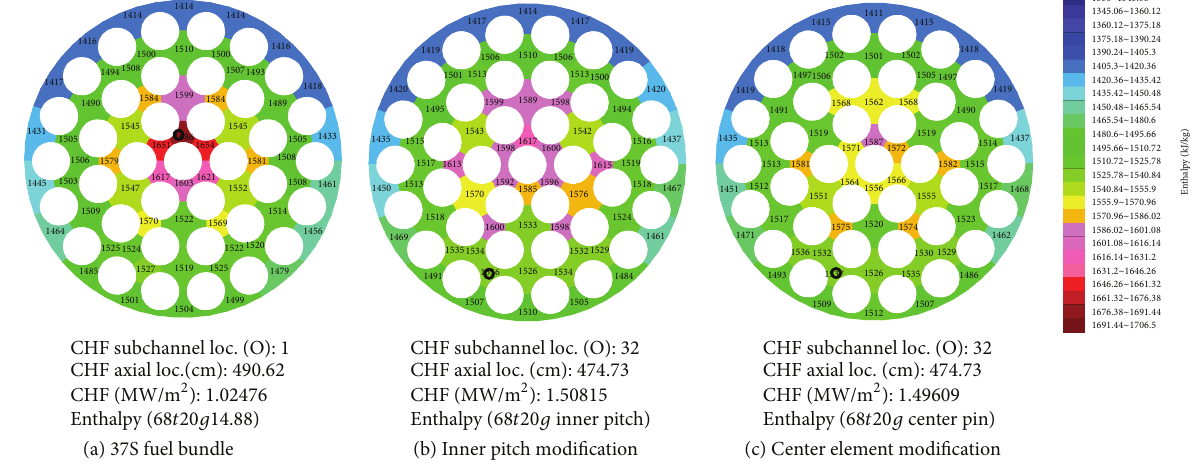
Figure 9: Enthalpy distributions of the standard 37-element fuel and its modifications for 268 ∘